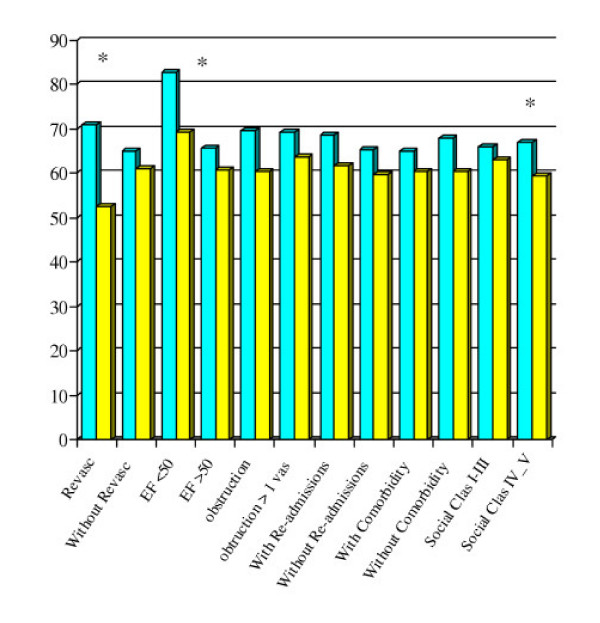
Clinical and demographic variables and vitality dimension score of the SF-36 health questionnaire at baseline and 3 months after discharge from hospital. (Cont'd)  Baseline.  3 Months.